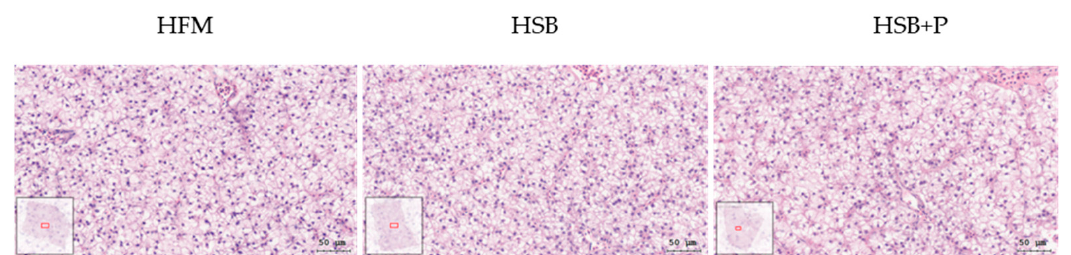
Figure 2. Histopathological examination under H&E (hematoxylin and eosin) staining of largemouth